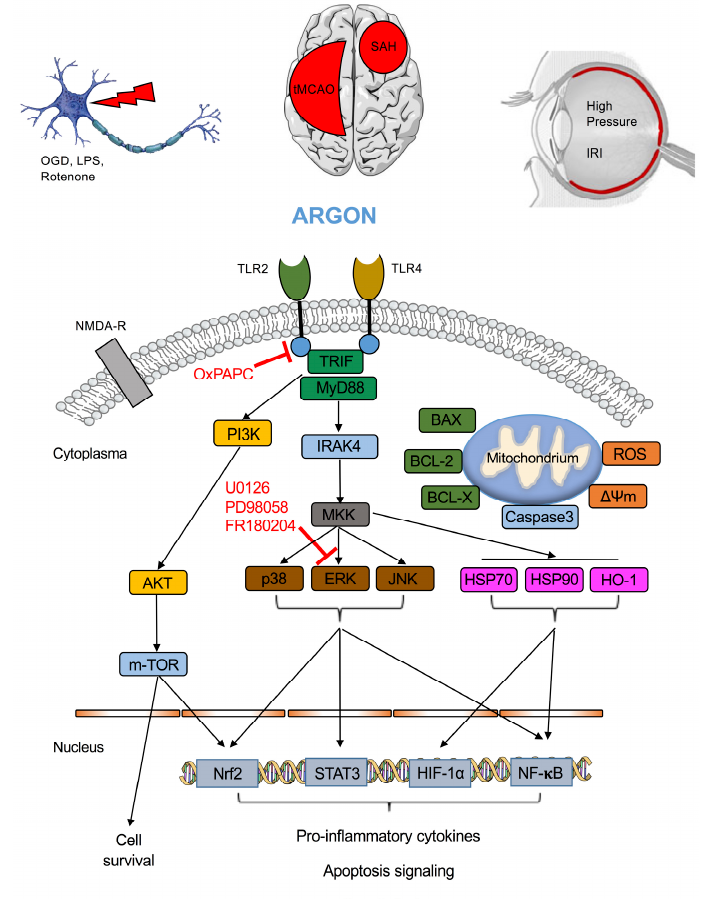
Figure 1. Argon’s molecular mechanism. Argon is able to specifically activated toll-like receptors 2 and 4, mediating intracellular signaling via IRAK4 and ERK1/2 (and to some amount p38) and inhibiting the heat shock response (HSP-70, -90 and HO-1) or activating the PI3K/mTOR pathway. Mitochrondrial signaling includes Bcl-2, Bcl-X and BAX expression, while ROS is reduced and mitochondrial membrane potential remains constant. These intracellular proteins lead to a differential activation or suppression of transcription factors, thus inducing or inhibiting effector genes and proteins (e.g., IL-8). OGD = oxygen-glucose deprivation, LPS = lipopolysaccharide, tMCAO = transient mid cerebral artery occlusion, IRI = ischemia and reperfusion injury, SAH = subarachnoid hemorrhage, NMDA-R = N -methyl D -aspartate receptor, TLR = toll-like receptor, TRIF = TIR-domain-containing adapter-inducing interferon- β , MyD88 = myeloid differentiation primary response gene 88, IRAK4 = interleukin-1 receptor-associated kinase 4, PI3K = phosphoinositide 3-kinase, AKT = protein kinase B, m-TOR = mechanistic Target of Rapamycin, MKK = mitogen-activated protein kinases, ERK = extracellular signal regulated kinase, JNK = c-Jun N-terminal kinase, BAX/BCL-2/BCL-X = apoptotic genes, ROS = reactive oxygen species, ∆Ψ m = mitochondrial membrane potential, HSP = heat shock protein, HO-1 = heme-oxygenase-1, Nrf2 = Nuclear factor (erythroid-derived 2)-like 2, STAT = signal transducer and activator of transcription, HIF-1 α = hypoxia inducible factor 1 α , NF- κ B = nuclear factor κ